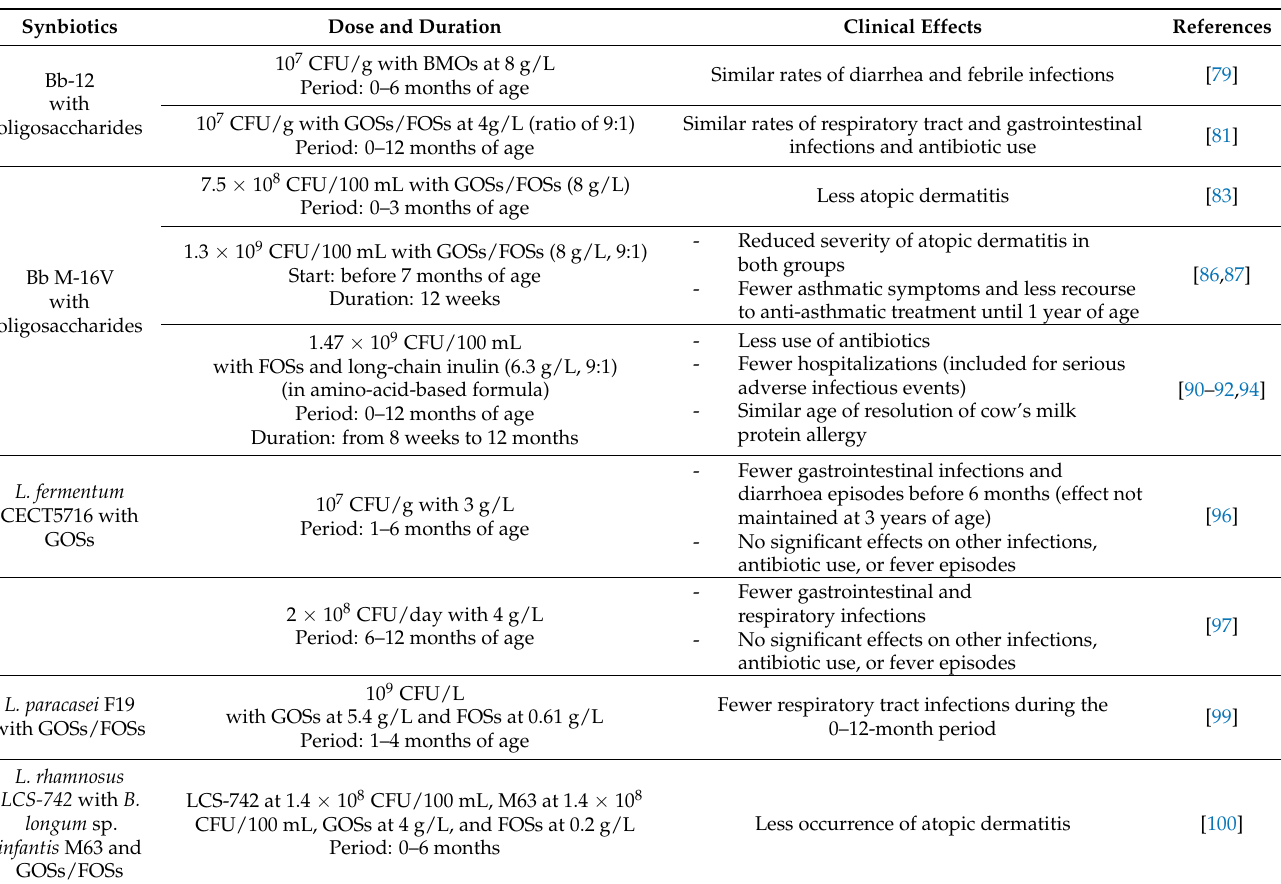
Table 3. Summary of clinical effects of synbiotics compared to control groups with non-supplemented infant